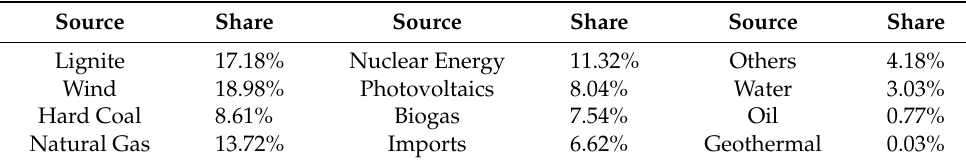
Table 7. Shares of German power grid mix in 2019 [56].